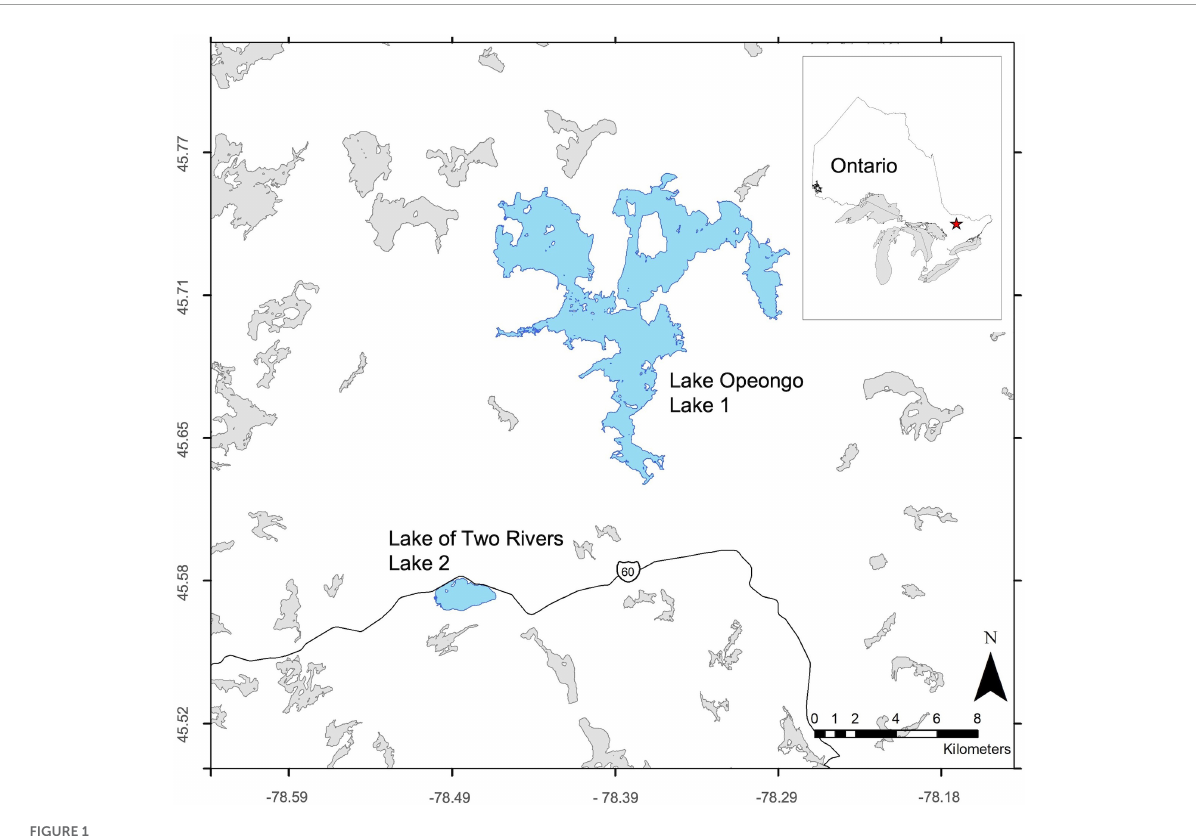
FIGURE1 Location of Lake Opeongo (Lake 1) and Lake of Two Rivers (Lake